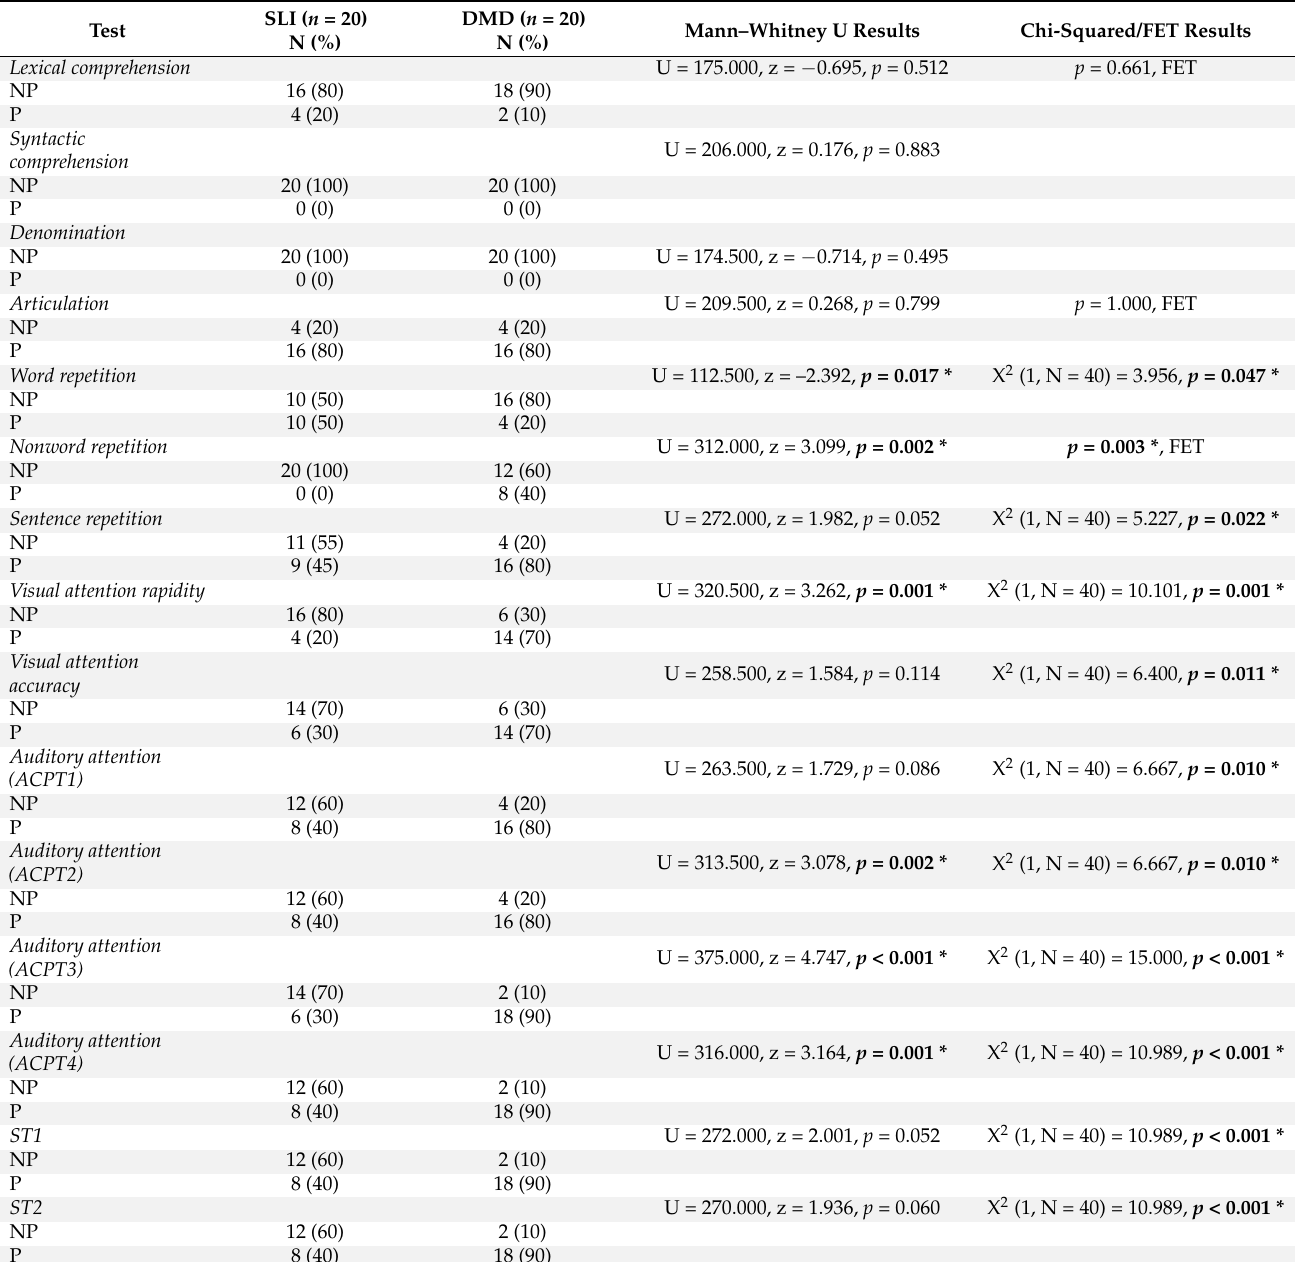
Table 1. Comparison of the specific language impairment (SLI) and Duchenne muscular dystrophy (DMD) groups regarding administered